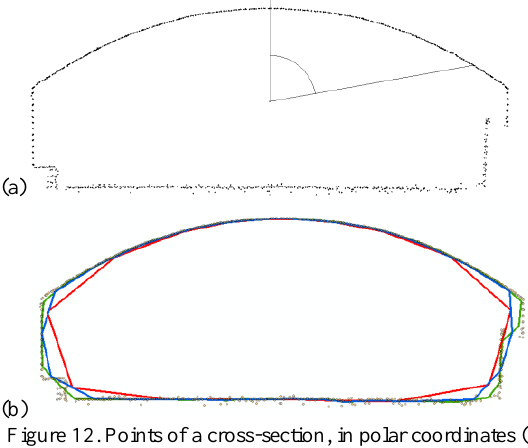
Figure 12. Points of a cross-section, in polar coordinates (a); adjustment of polylines at angular steps of 5º, 10º and 20º